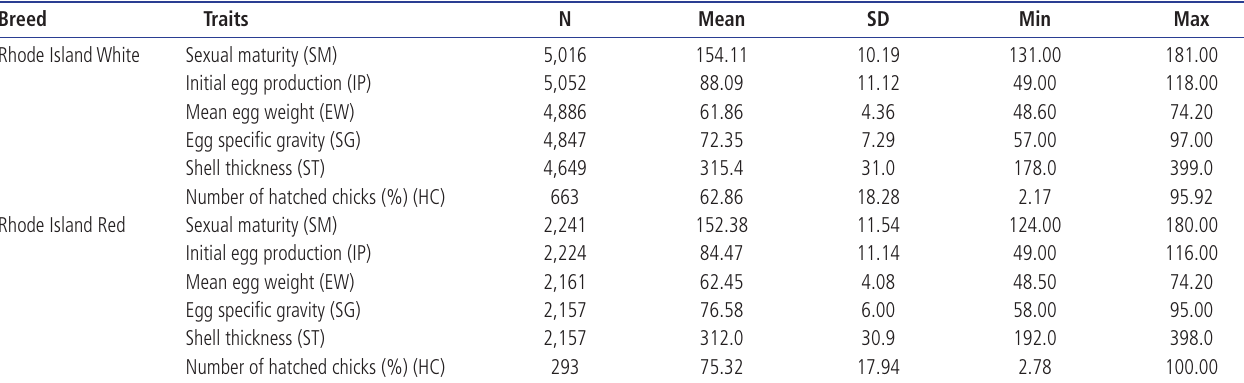
Table 1. Mean value of performance traits in Rhode Island Red and Rhode Island White Breed